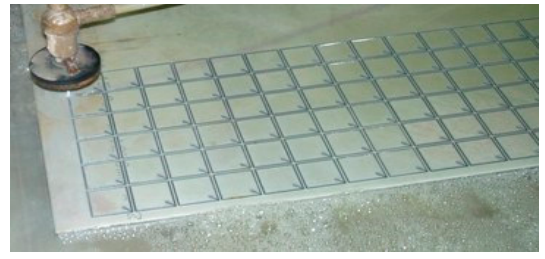
Figure 2. Cutting of test samples.